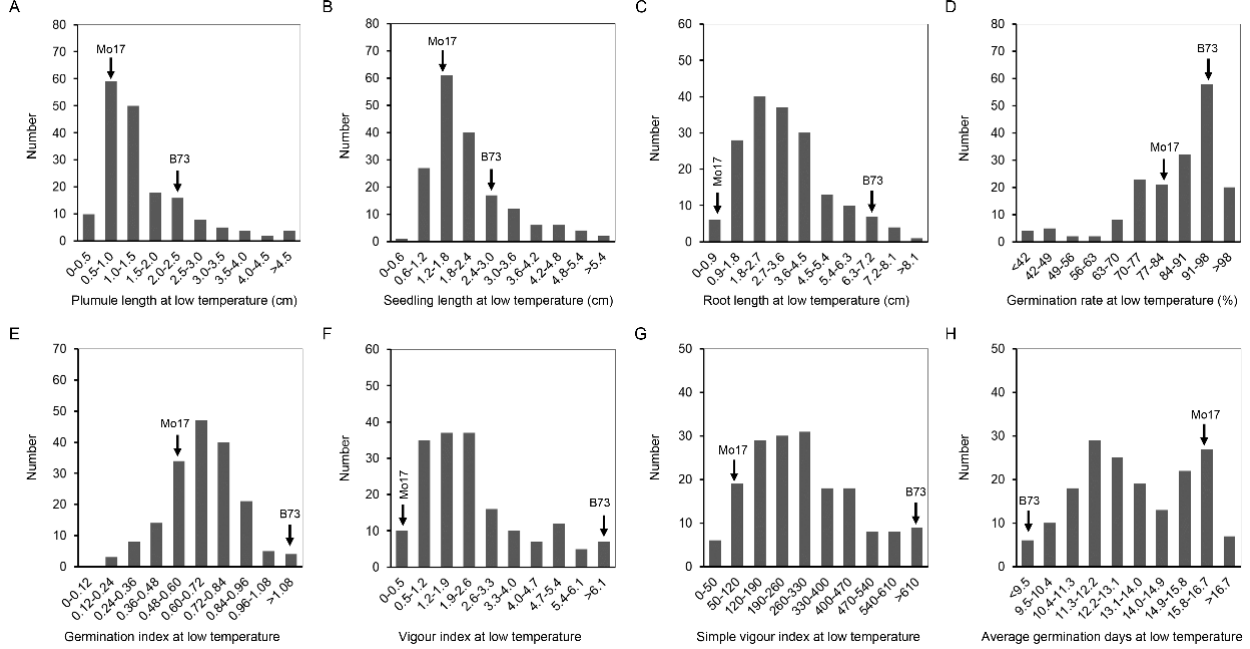
Figure 3. The histogram of frequency distribution of germination-related traits under 4 °C in IBM Syn10 DH population. ( A ) Plumule length at low temperature (LTPL); ( B ) seedling length at low temperature (LTSL); ( C ) root length at low temperature (LTRL); ( D ) germination rate at low temperature (LTGR); ( E ) germination index at low temperature (LTGI); ( F ) vigor index at low temperature (LTVI); ( G ) simple vigor index at low temperature (LTSVI); ( H ) average germination days at low temperature (LTAGD).